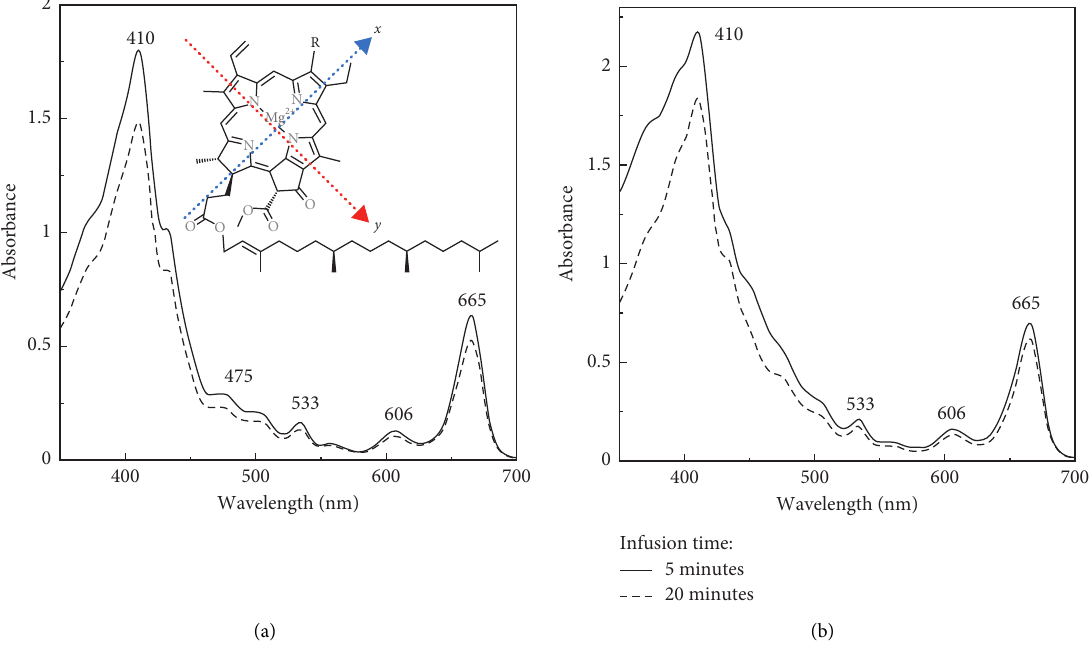
Figure 3: The absorption spectra of the pigments extracted from tea dregs of green (a) and black teas (b) after 5 and 20 min of hot water infusion at 90 ° C. Figure 3(a) shows the diagonal arrows for the direction of two polarization axes in the structure of chlorophyll, x and y , contributing to the absorption band at 665nm (Qy band), 533 (Qx band), and 410 nm (overlapped Soret band).